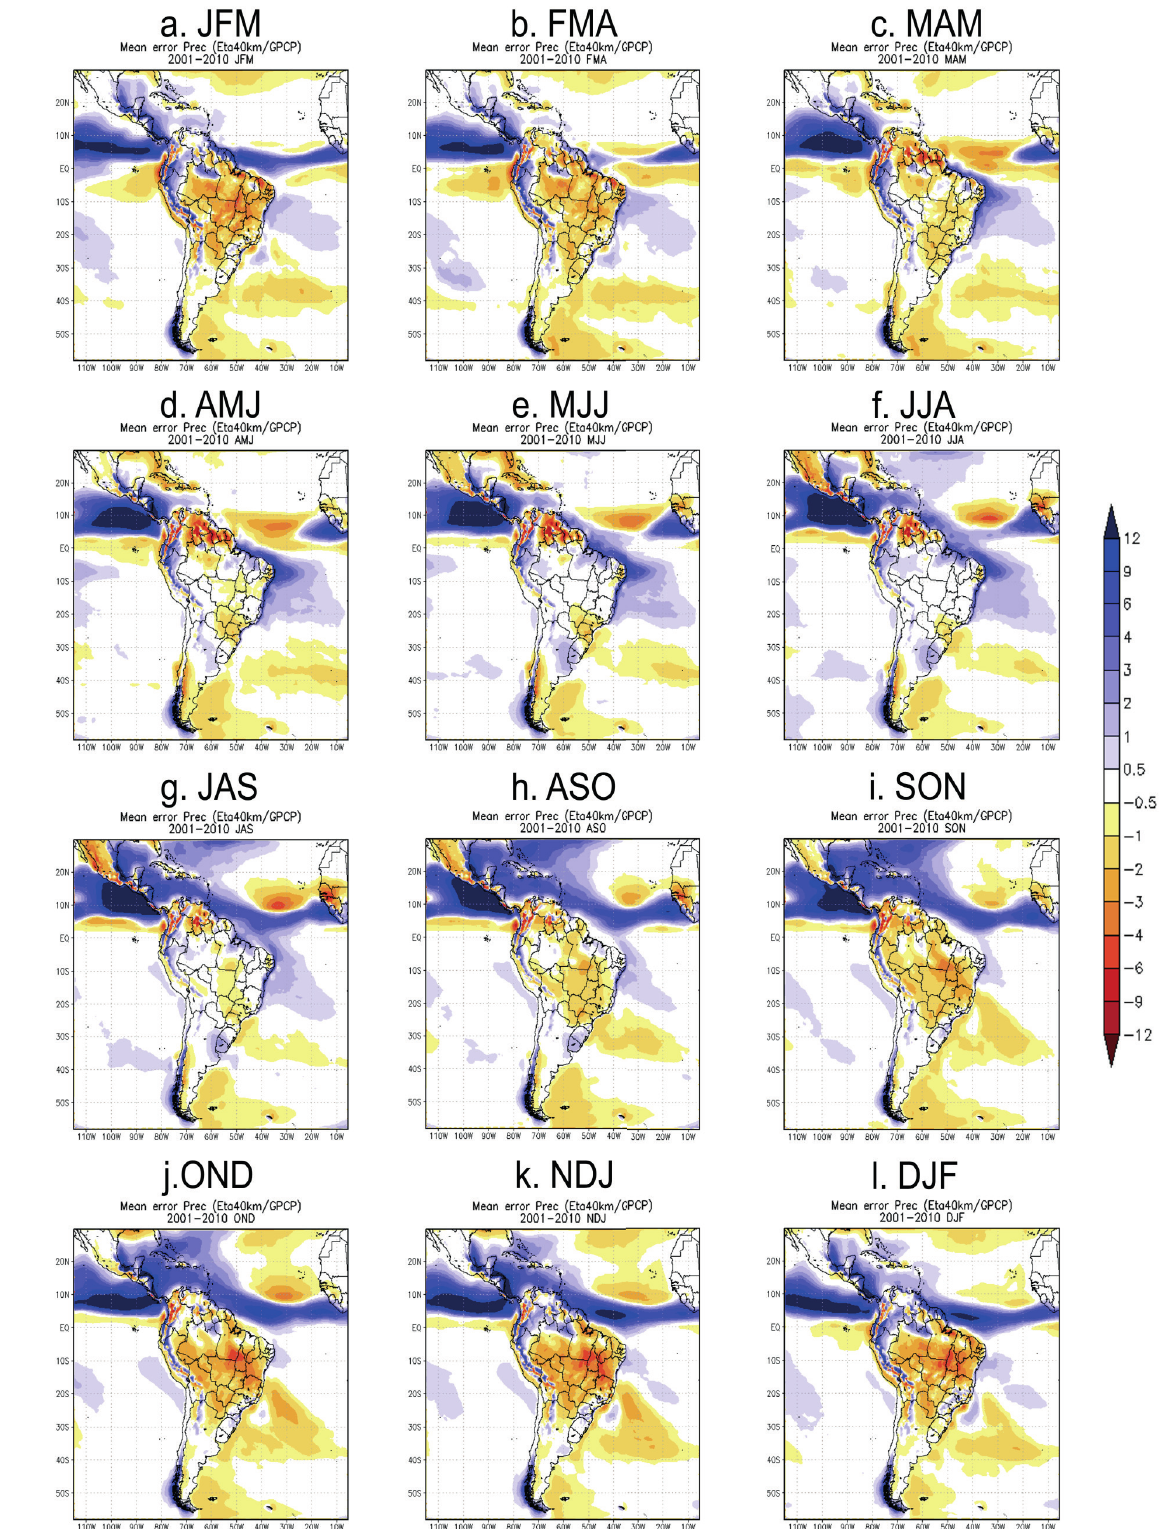
Figure 3. Mean errors of seasonal precipitation (mm/3 months) for one-month lead time